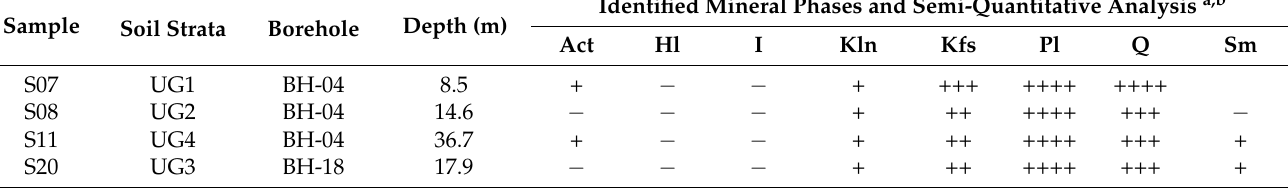
Table 3. Mineralogical composition of the selected soil samples.